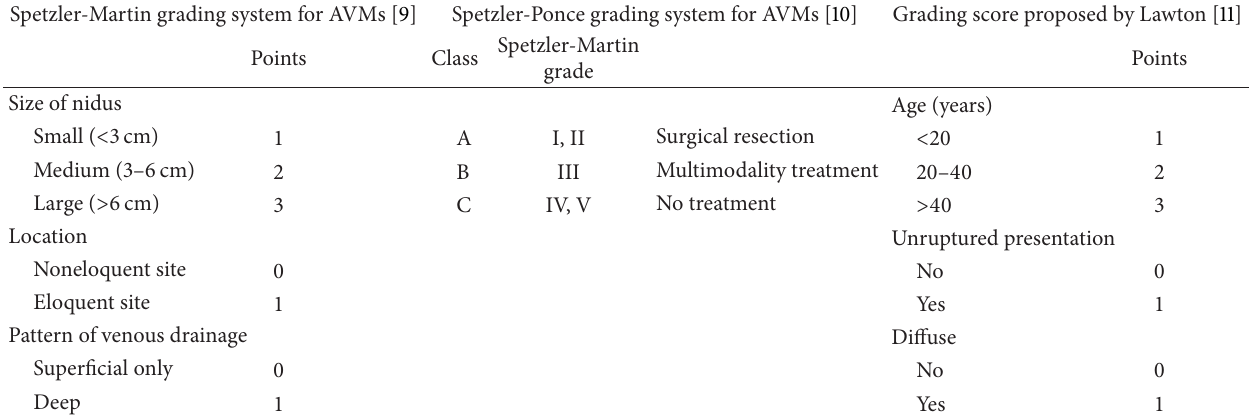
Table 1: Grading systems for